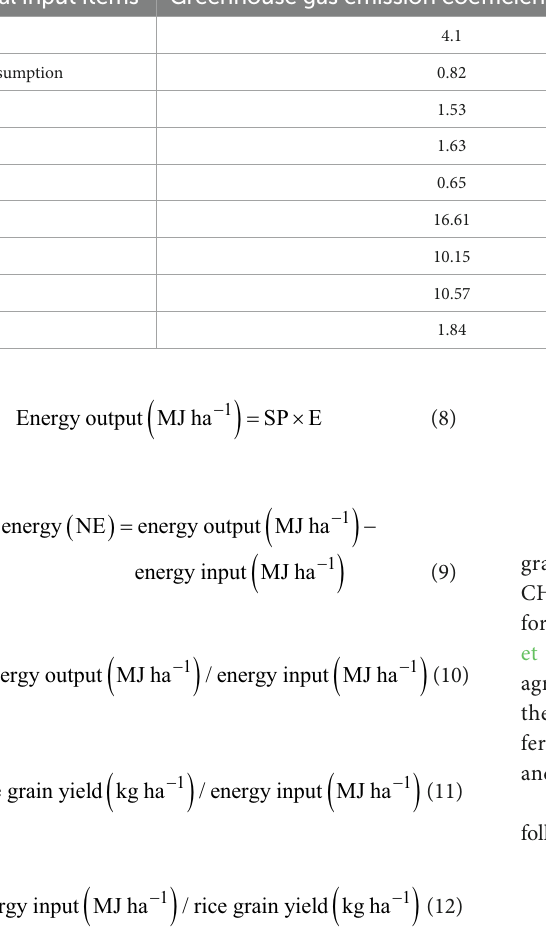
TABLE 3 Greenhouse gas emission coefficients and energy utilization coefficients of different agricultural inputs. Agricultural input